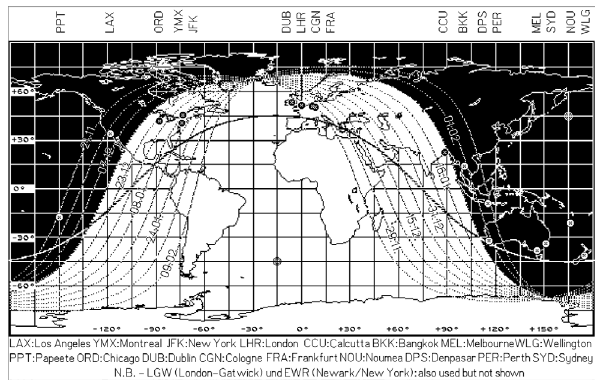
Figure 10: Zero Crossing : Equirectangular World Map with Airports of Call, neighbouring Great